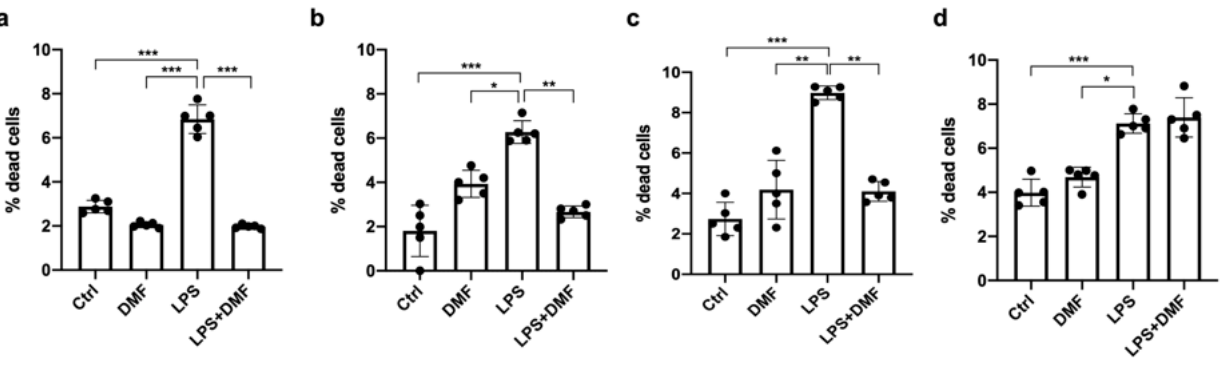
Figure 5. Cell viability in Oli neu cells after LPS and DMF treatment. Oli neu cells were plated in sextuplicate and treated with vehicle (DMSO) (Ctrl), DMF 25 µ M, LPS 1 µ g/mL and LPS+DMF. After ( a ) 24 h, ( b ) 48 h, ( c ) 72 h and ( d ) 120 h of treatment, the cells were counted by LUNA-FX7™ using trypan blue dye. The graph, showing the percentage of dead cells, was obtained from the average ± SEM of five independent experiments. One-way ANOVA test followed by the Tukey multiple comparison post-test was used to statistically compare the different experimental conditions (* p < 0.05; ** p < 0.01; *** p < 0.001).